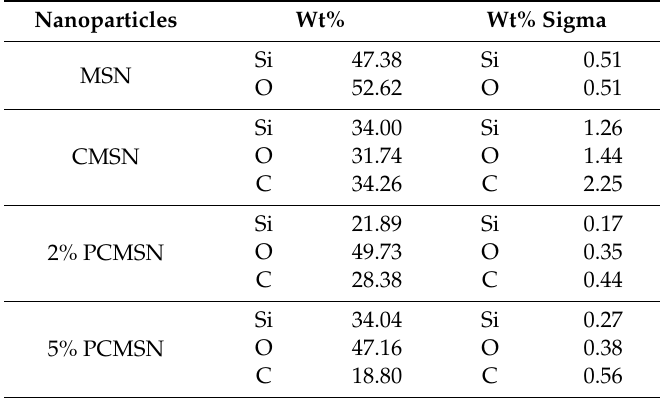
Figure 3. FTIR spectra of MSN, chitosan-MSN (CMSN), 2% PEG-chitosan-MSN (2% PCMSN), and 5% PEG-chitosan-MSN (5% PCMSN). Table 2. EDX Data obtained from scanning electron microscopy (SEM) images.